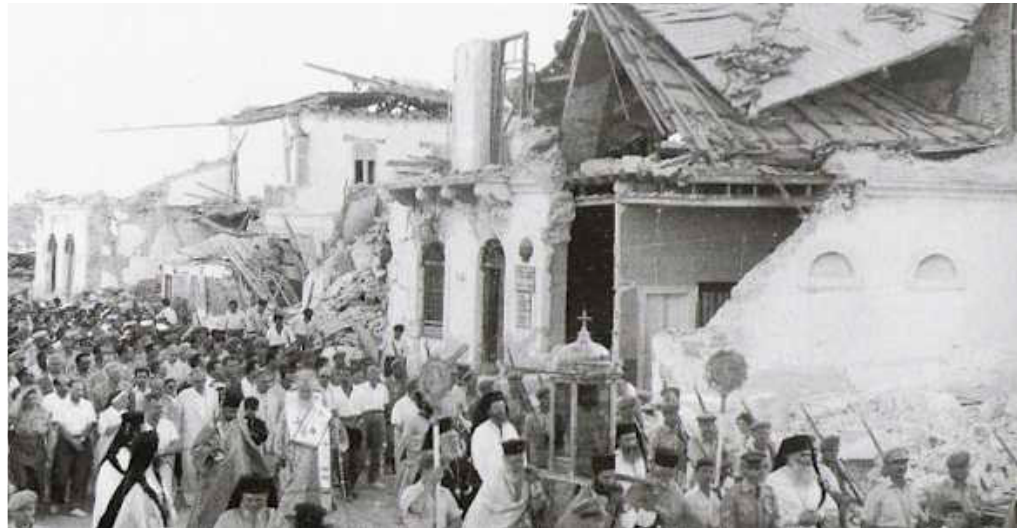
Figure 22. Images of total destruction to old masonry construction in Argostoli, Kefalonia island during the 1953 earthquake sequence.